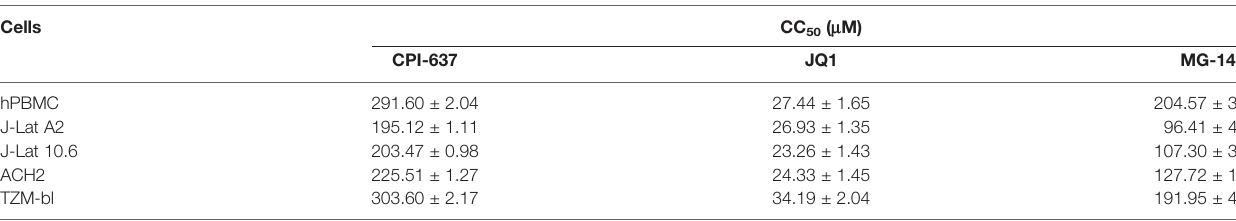
TABLE 2 | In vitro cytotoxicity of CPI-637. Cells